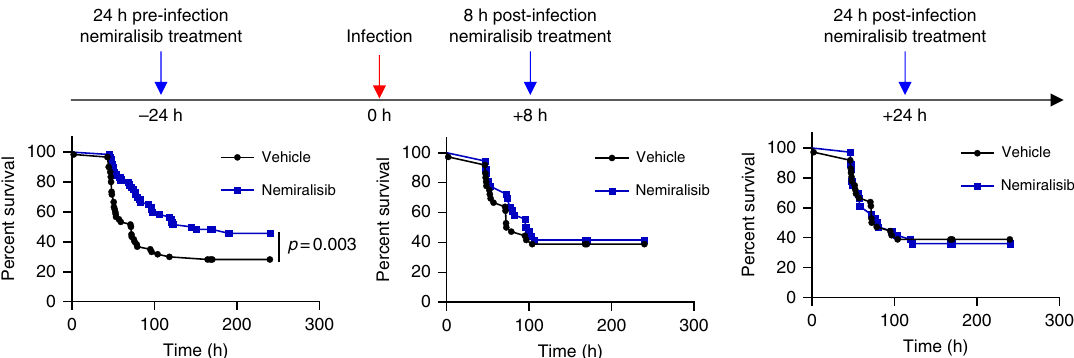
Fig. 1 Prophylactic, but not therapeutic treatment with the inhaled PI3K δ inhibitor nemiralisib mitigates disease severity following S. pneumoniae infection in wild-type mice. Wild-type mice were treated twice daily with the inhaled PI3K δ inhibitor nemiralisib for the duration of the study: when treatment was started 24 h prior to infection with S. pneumoniae serotype 4, TIGR 4, survival rates were improved. When started 8 or 24 h post-infection, the treatment had no effect on survival outcome. ( − 24 h: data from fi ve independent experiments combined n = 60; + 8 h/ + 24 h: data from three independent experiments combined n = 36; data-points represent individual